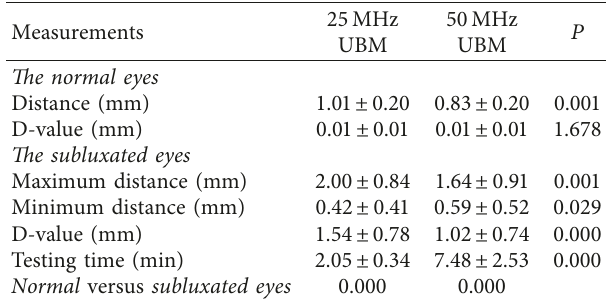
Figure 3: Slightly subluxated lens with traumatic cataract images obtained in the same patient with 25 and 50MHz UBM. (a) A 25MHz UBM image clearly shows a slightly subluxated lens, the anterior and posterior capsular tear of the lens (arrows), and the opacity of whole lens; (b) an axial image of 50MHz UBM shows only the tear and opacity of the anterior lens capsule (arrow); other lens lesions were not shown clearly, especially in the posterior capsule of the lens; and the tear location could not be seen; (c–f) the longitudinal section images of 50MHz UBM show only the tear and opacity of the anterior lens capsule (arrow), and the differences in the distance between the lens equator and the ciliary process in these figures were not significantly different. Table 1: The measurements of lens position in normal and sub- Table 3: Comparison among normal subjects and slight and other luxated subjects obtained with 25MHz and 50MHz UBM. subluxations of 25 MHz